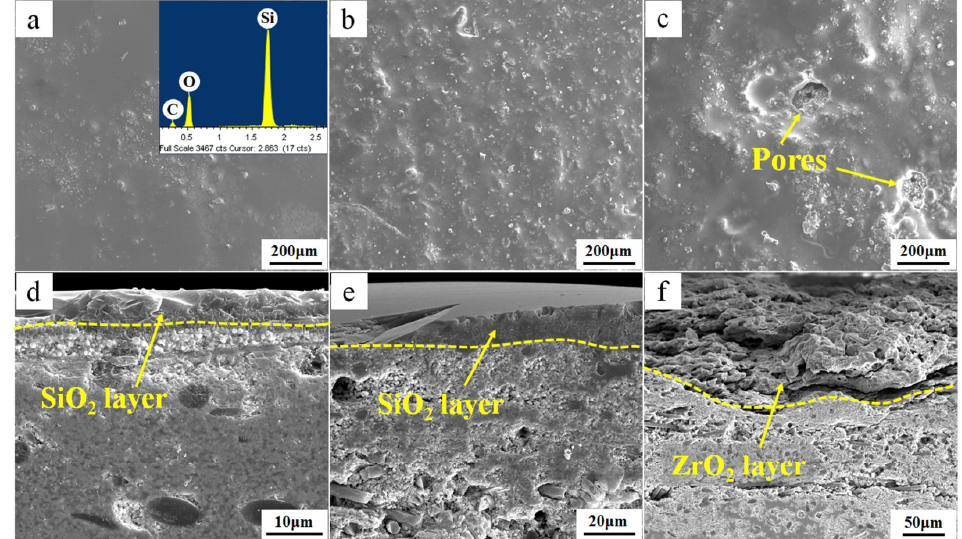
Fig. 10 SEM images of the surfaces and cross-sections of (a, d) ZSC30, (b, e) ZSC40, and (c, f) ZSC50 after oxidation at 1500 ℃ in static air for 1 h, showing a good oxidation resistance for ZSC30 and